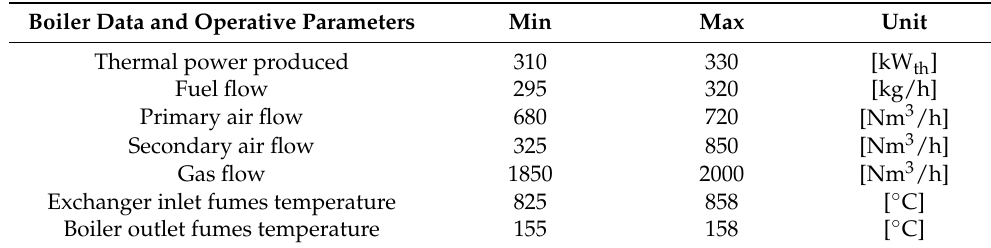
Table 1. Boiler data at combustion test